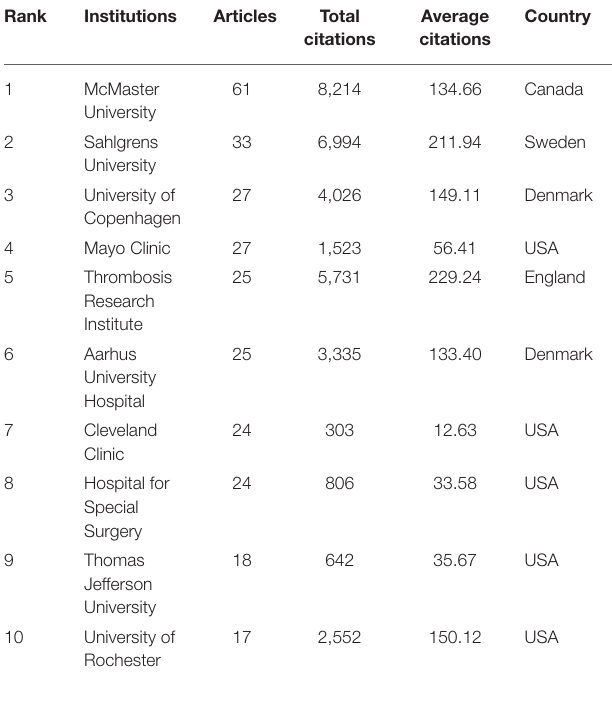
TABLE 2 | List of top 10 contributing institutions and their countries.